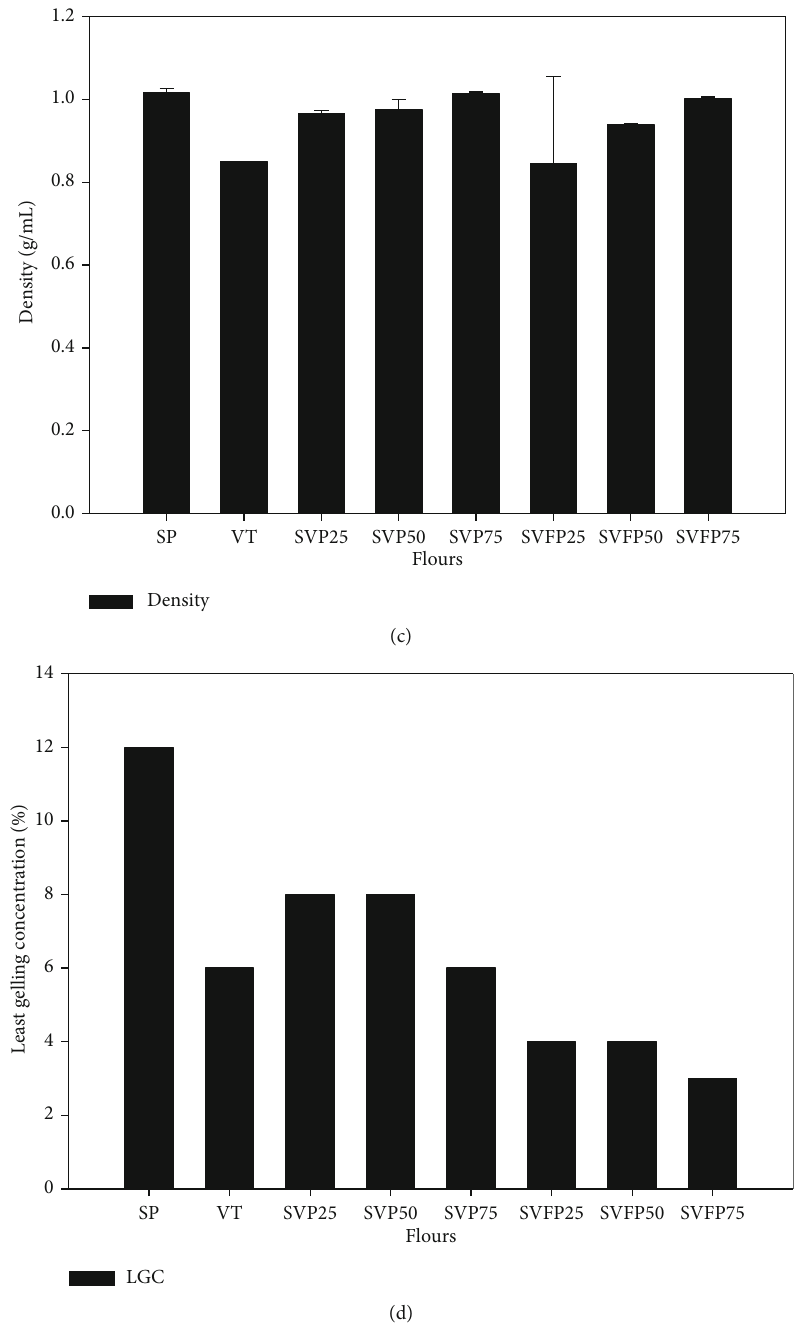
Figure 3: Water absorption capacity (a), solubility (b), density (c), and the least gelling concentration (d) of fl ours. SP: precooked dehulled sorghum fl our; VT: roasted dehulled Bambara Flour; SVP25: blended fl our containing 25% of precooked sorghum fl our and 75% of roasted Bambara fl our; SVP50: blended fl our containing 50% of precooked sorghum fl our and 50% of roasted Bambara fl our; SVP75: blended fl our containing 75% of precooked sorghum fl our and 25% of roasted Bambara fl our; SVFP25: fermented fl our containing 25% of precooked sorghum fl our and 75% roasted Bambara fl our; SVFP50: fermented fl our containing 50% precooked sorghum fl our and 50% roasted Bambara fl our; SVFP75: fermented fl our containing 75% precooked sorghum fl our and 25% roasted Bambara fl